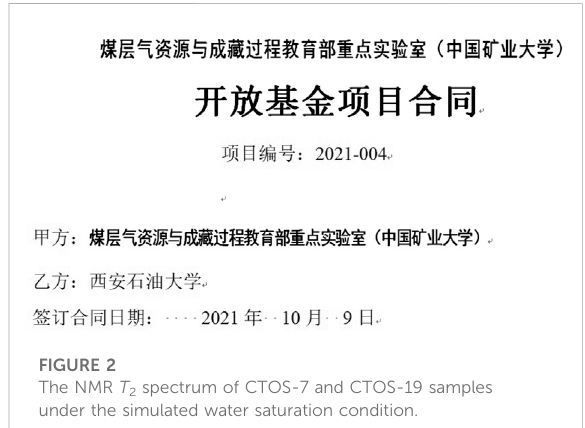
FIGURE 2 The NMR T 2 spectrum of CTOS-7 and CTOS-19 samples under the simulated water saturation